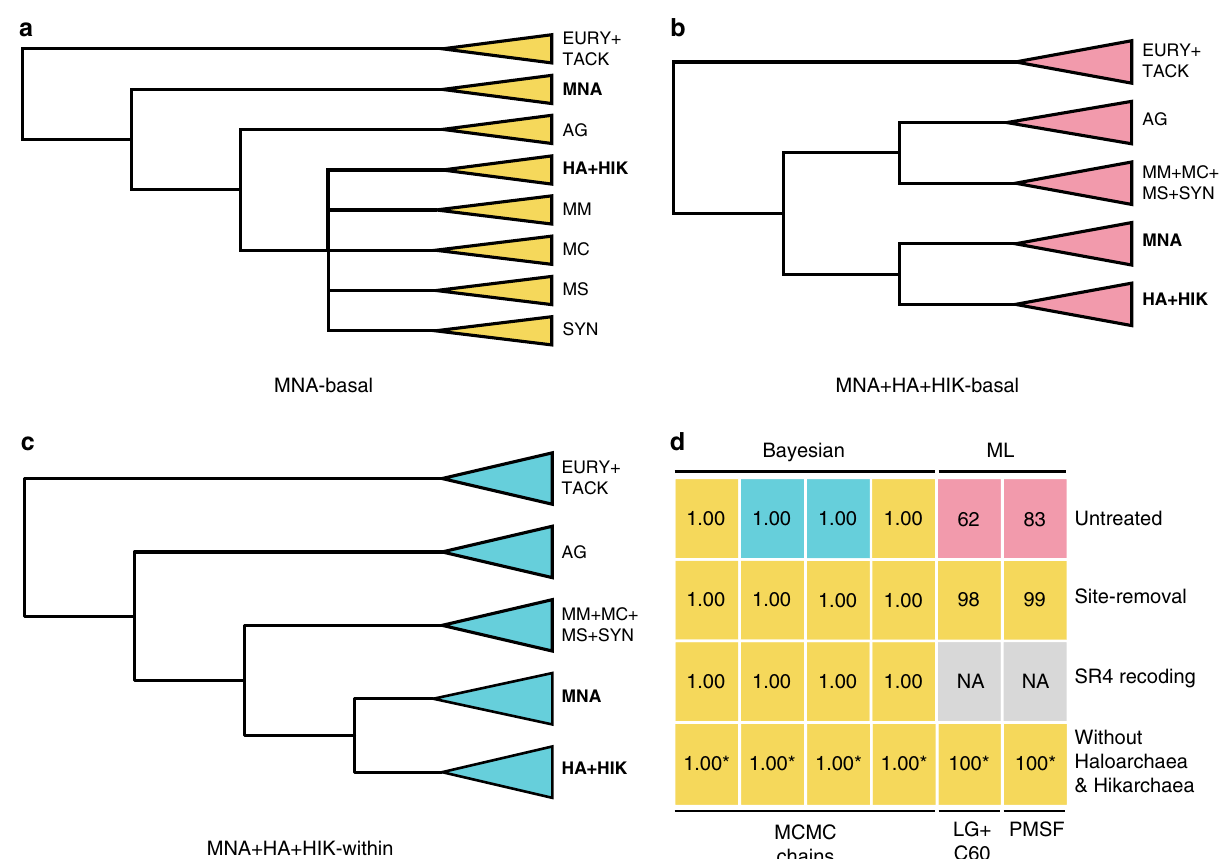
Fig. 2 Resolving the branching order within Methanotecta. a – c Different species tree topologies for placement of the Methanonatronarchaeia. These trees represent the topological constraints used for the AU tests and branch support enumeration (Supplementary Table 4). Note that the polytomy in ( a ) does not necessarily indicate unresolved branch support in the inferred species trees, but rather freedom in the topological constraint during AU tests and branch support enumeration. EURY euryarchaeota, TACK TACK archaea, MNA methanonatronarchaeia, AG archaeoglobi, HA haloarchaea, HIK different topologies in ( a – c ) using several alignment treatments and phylogenetic models/reconstruction methods. Asterisk (*): due to omission of Hikarchaeia and Haloarchaea, MNA + HA + HIK-basal and MNA-basal topologies are equally well